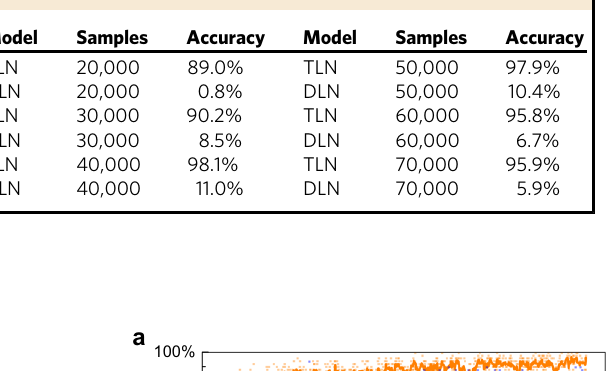
Table 2 Comparison between TLN and conventional DLN.